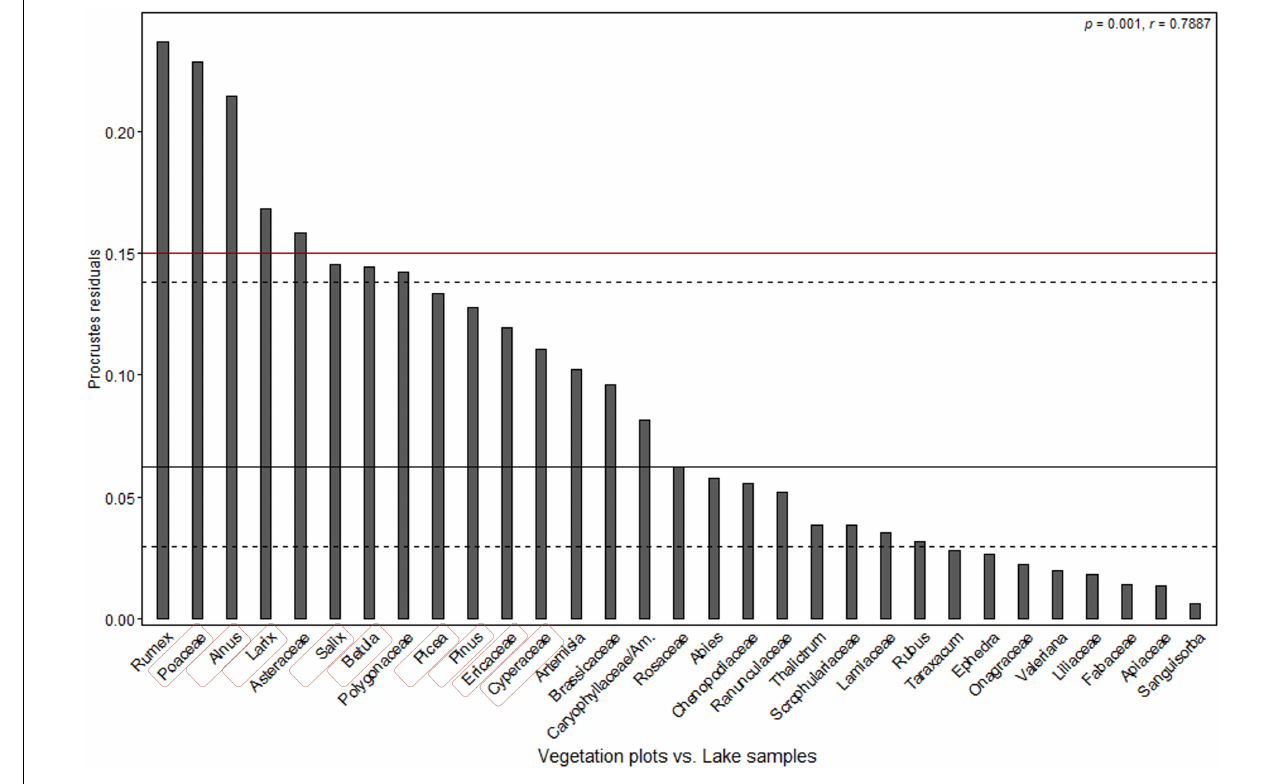
FIGURE 5 | PROCRUSTES residuals plot of comparison between principal component analysis (PCA) taxa scores of moss/soil samples and lake samples (ordered according to the residual scores). Dashed and solid lines are the first, second, and third quartiles. The p -value indicates the likelihood of the relationship occurring by chance and the r -value reflects the correlation between the two ordination results. Taxa used in ERV model were highlighted in red rectangle.